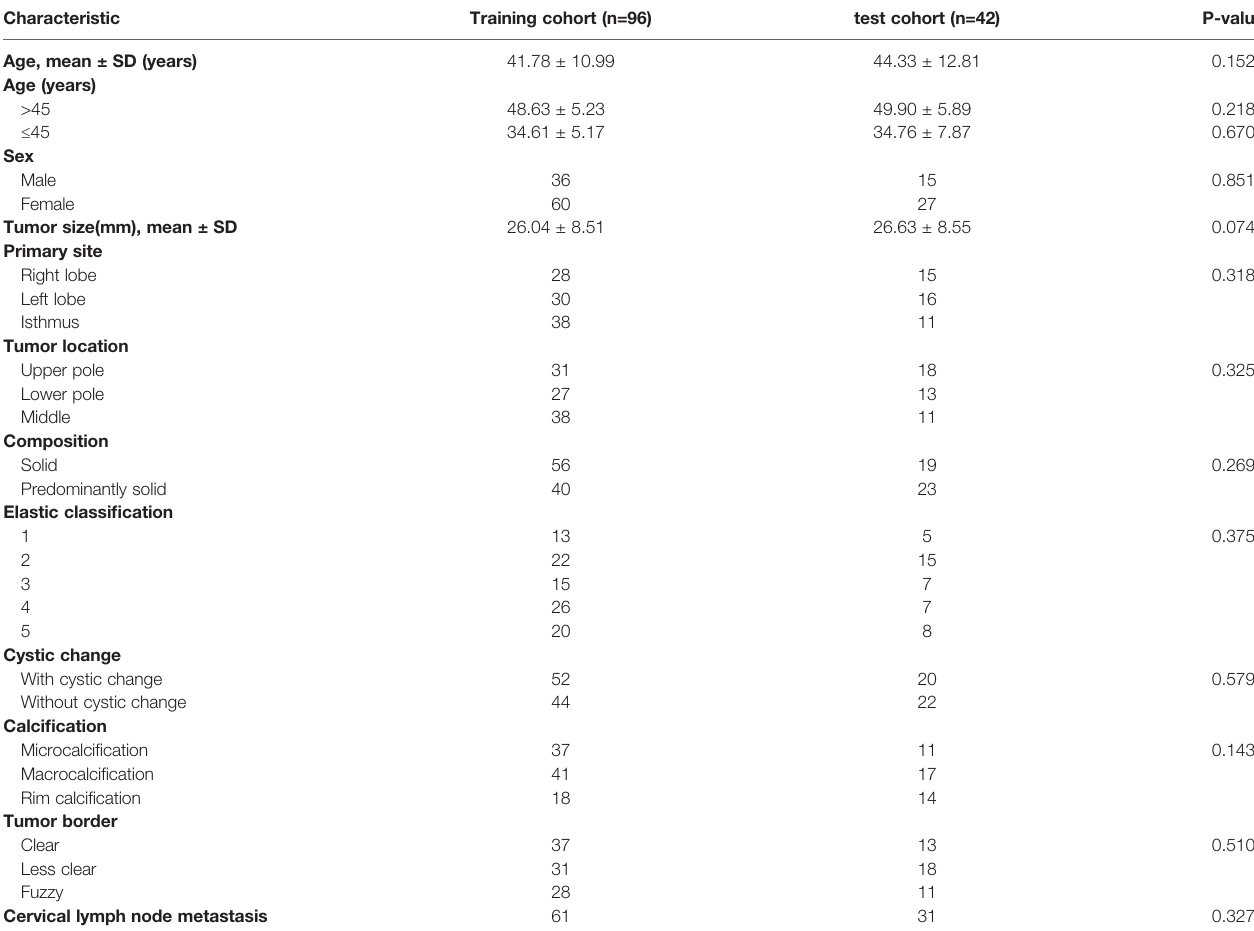
TABLE 1 | Clinical characteristics of the patients in the training and test cohorts.